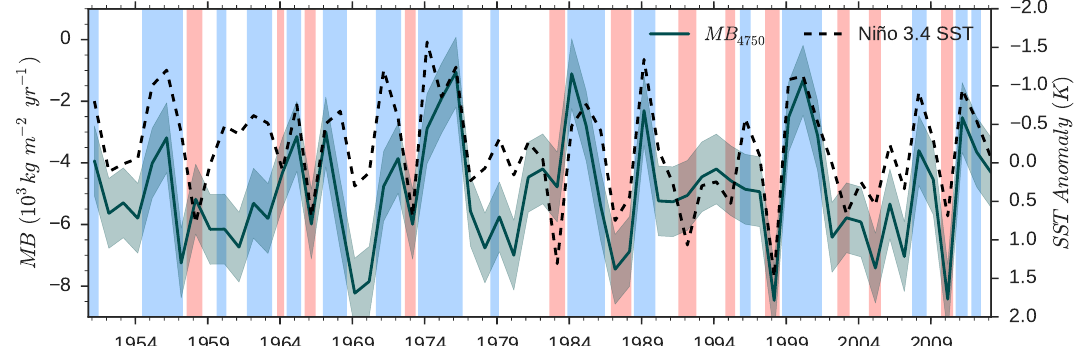
Figure A3. Same as Fig. 8 but using NCEP/NCAR R1 reanalysis and for the period 1951–2013.